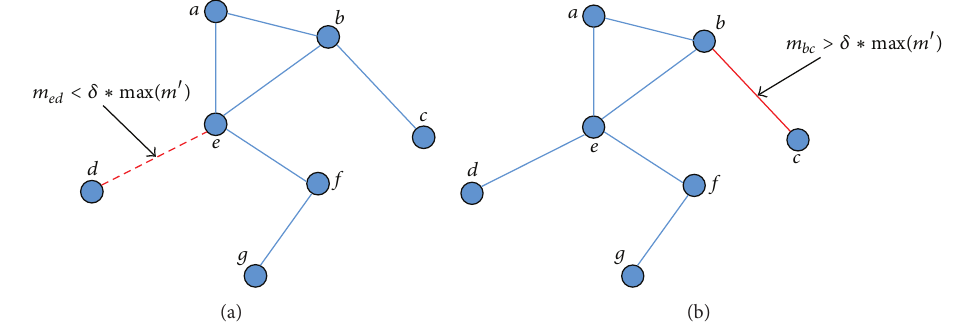
Figure 2: Two events cause the structure variation of network. (a) A link between nodes 𝑏 and 𝑐 is added into the network because 𝑚 󸀠 𝑏,𝑐 > 𝛿 ∗ max (𝑚 󸀠 ) . (b) A link between nodes 𝑑 and 𝑒 is removed from the network because 𝑚 󸀠